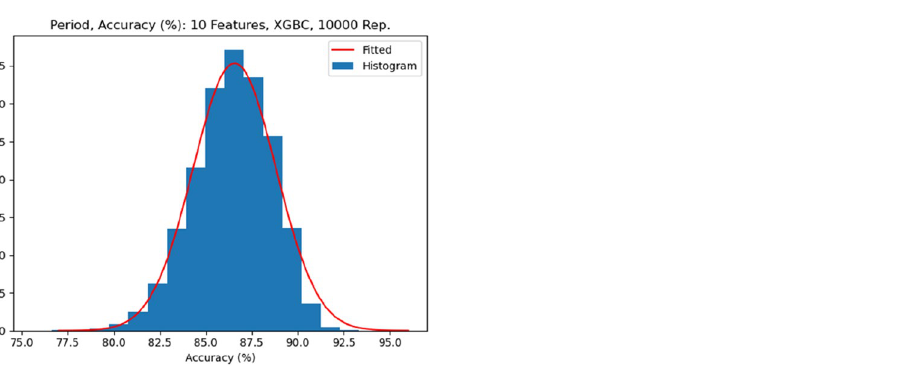
Figure 6. Period Change Dataset, histogram, and fitted normal probability density function of the accuracies for 10,000 replications of XGBC applied to final 10 molecular